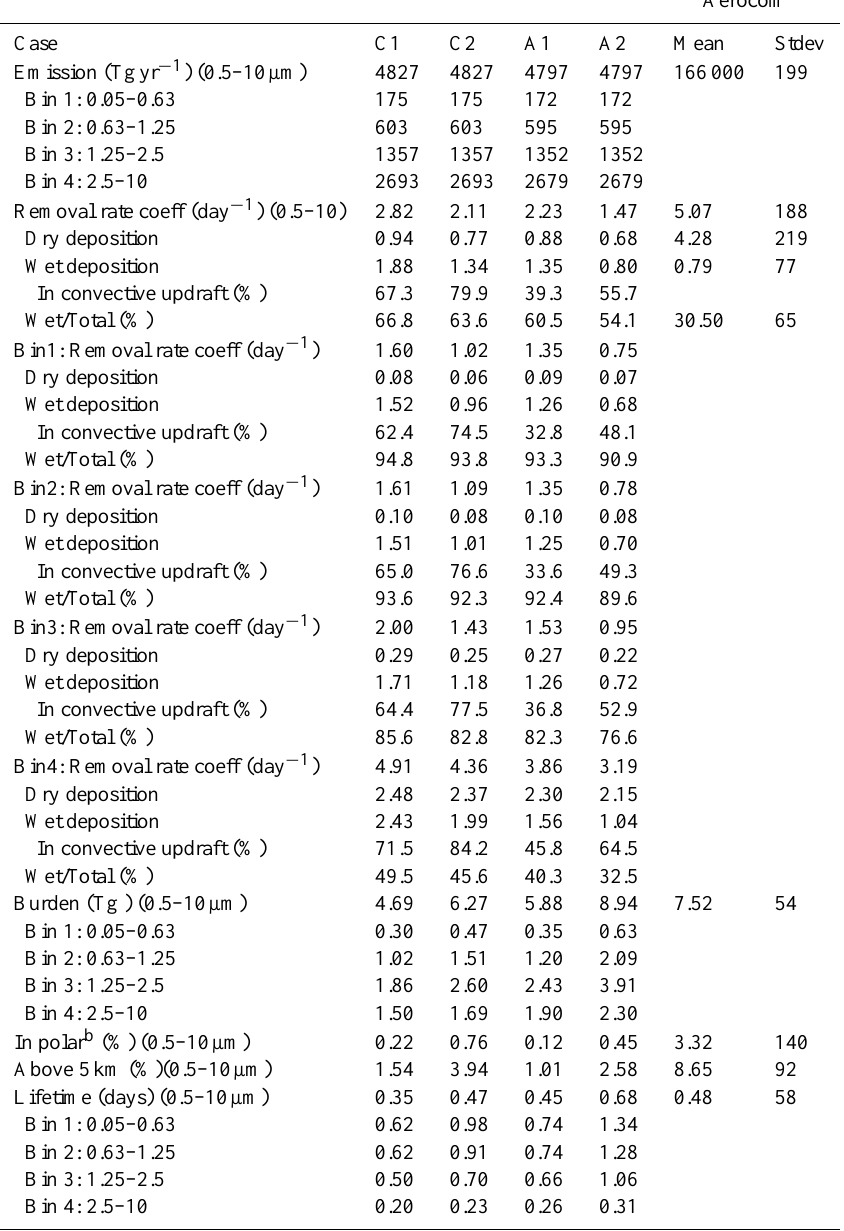
Table 7. Global budget of sea